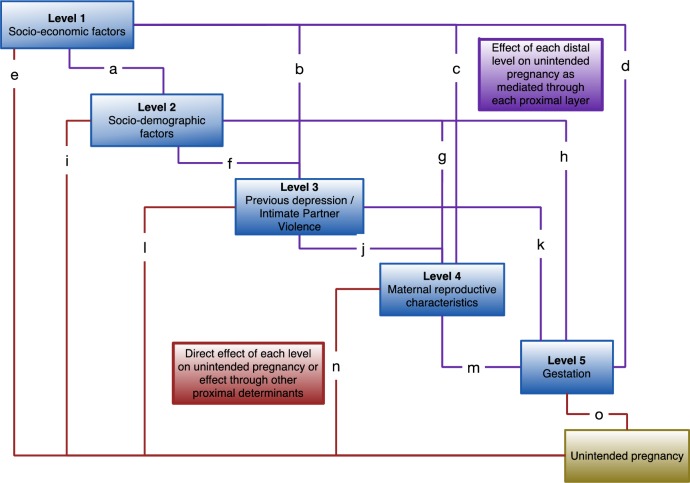
Conceptual hierarchical framework of risk factors for unintended pregnancy.